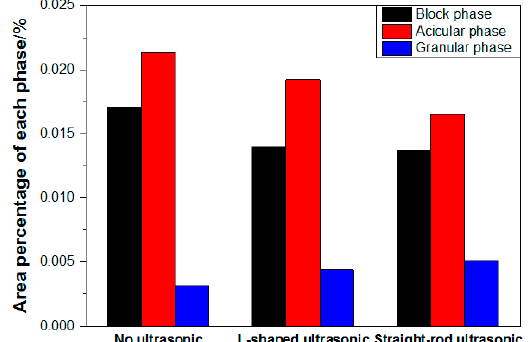
Figure 8. Distribution of the secondary phase in the grain at the 1 / 2 radius: ( a ) No ultrasonic treatment; ( b ) treatment by the L-shaped ultrasonic wave guide rod; ( c ) treatment by the straight-rod ultrasonic wave guide rod.